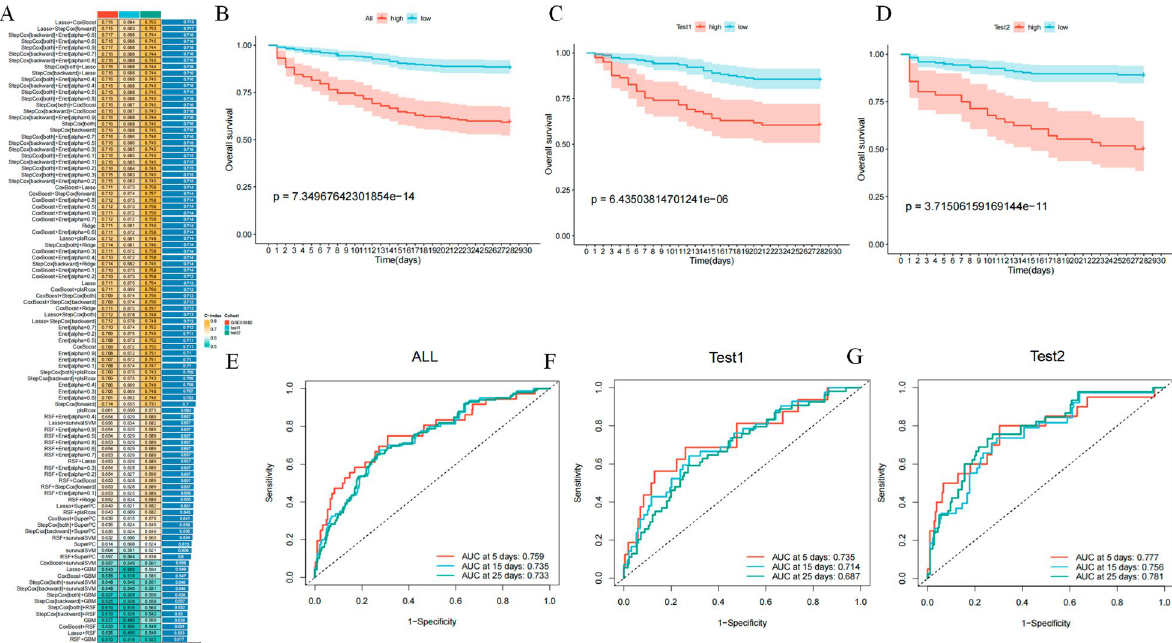
Fig. 3 Establishment of a prognostic signature related to monocyte differentiation in patients with sepsis. A C-index values of 99 machine learning combinations. The color from green to yellow represents the gradual increase of C-index value. Each row represents a signature and each column represents a cohort; B Survival analysis of the total cohort of high-risk and low-risk patients. Blue represents low-risk patients and red represents high-risk patients; C Survival analysis of the Test 1 cohort of high-risk and low-risk patients. Blue represents low-risk patients and red represents high-risk patients; D Survival analysis of high-risk and low-risk patients in the Test 2 cohort; E ROC analysis of risk scores for the total cohort. Red represents the AUC of signature at 5 days, blue represents the AUC of signature at 15 days, and green represents the AUC of signature at 25 days; F ROC analysis of risk scores for the Test 1 total cohort. Red represents the AUC of signature at 5 days, blue represents the AUC of signature at 15 days, and green represents the AUC of signature at 25 days; G ROC analysis of the risk scores of the total cohort in Test 2. Red represents the AUC of signature at 5 days, blue represents the AUC of signature at 15 days, and green represents the AUC of signature at 25